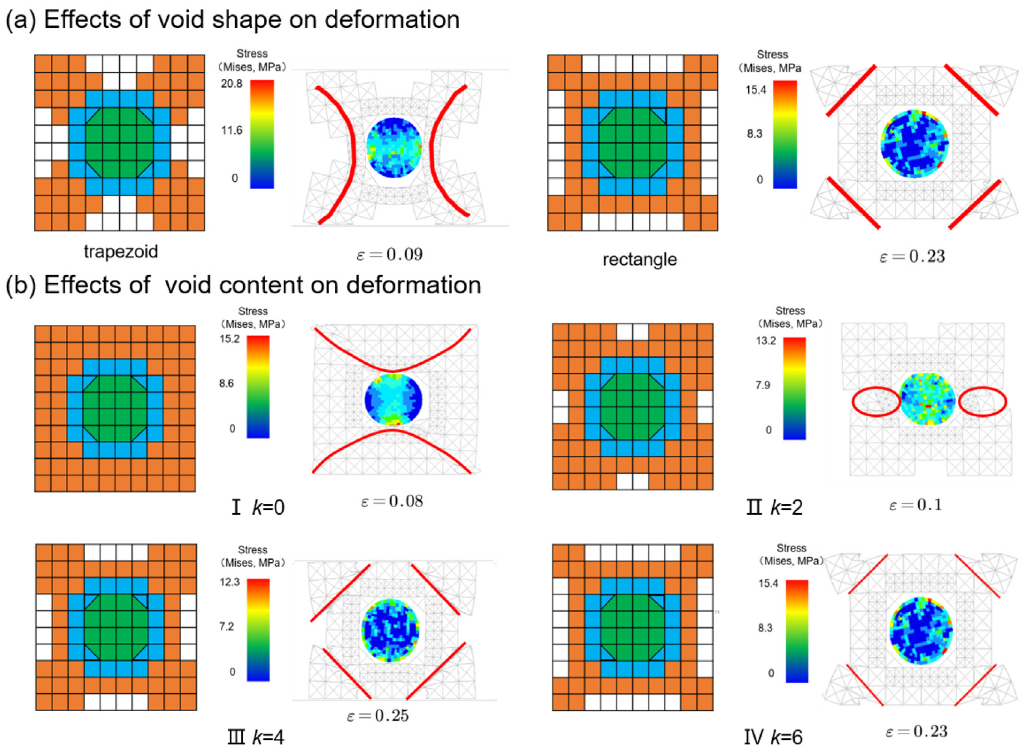
Fig. 3. The role of voids/defects on deformation. (a) Effects of void shape on deformation; (b) Effects of void content on deformation, and (I – IV) corresponds to the numbers of void-phase unit k varying from 0, 2, 4, and 6.